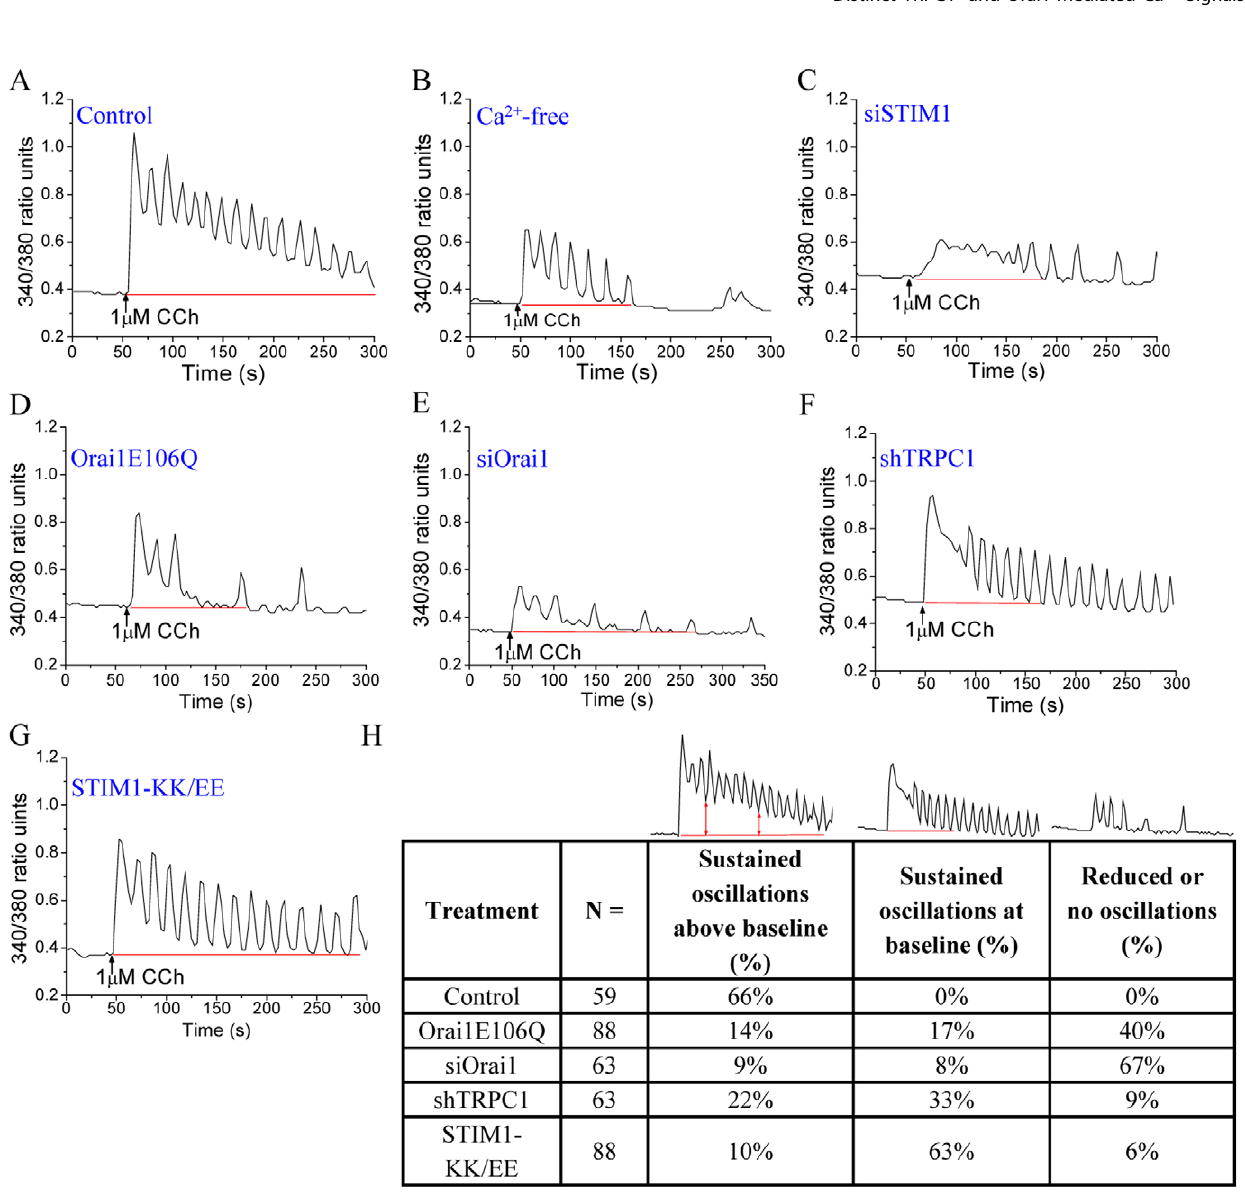
Figure 2. TRPC1 and Orai1 contribute distinct [Ca 2 + ] i changes in individual HSG cells following CCh stimulation. Ca 2 + oscillations in single cells following relatively low [CCh] (1 m M) stimulation of control HSG cells, with and without extracellular Ca 2 + ( A and B ); or cells expressing siSTIM1 ( C ), Orai1E106Q ( D ), siOrai1 ( E), shTRPC1 ( F ) or STIM1-KK/EE ( G ). Each trace is representative of $ 50 cells in at least 3 separate experiments (all traces shown were obtained from a single experiment). ( H ) Different oscillatory patterns seen in control cells as well as the changes induced by loss of TRPC1 or Orai1 function. Cells showing the various oscillatory patterns were counted and shown as percentage (%) of total cells (N). Cells showing sustained, non-oscillatory responses, or no responses were excluded from the